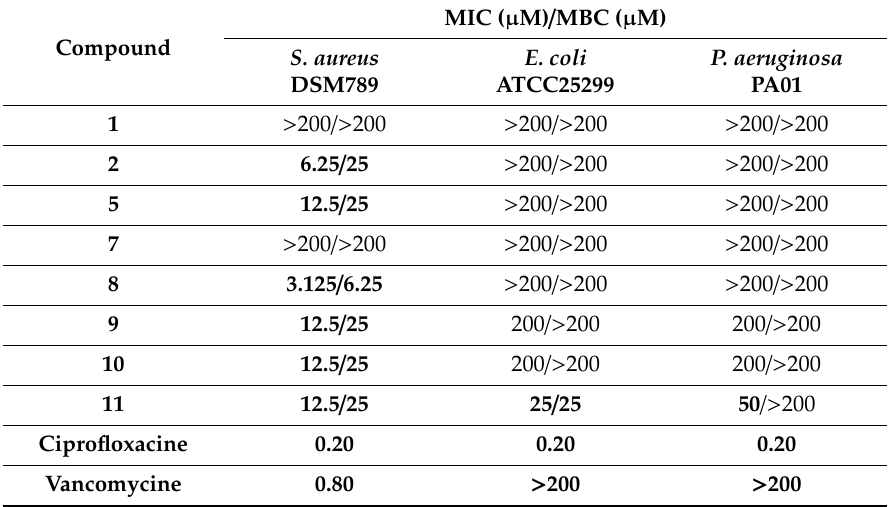
Table 1. Minimum inhibitory concentrations and minimum bactericidal concentration of compounds 1 , 2 , 5 , and 7 – 11